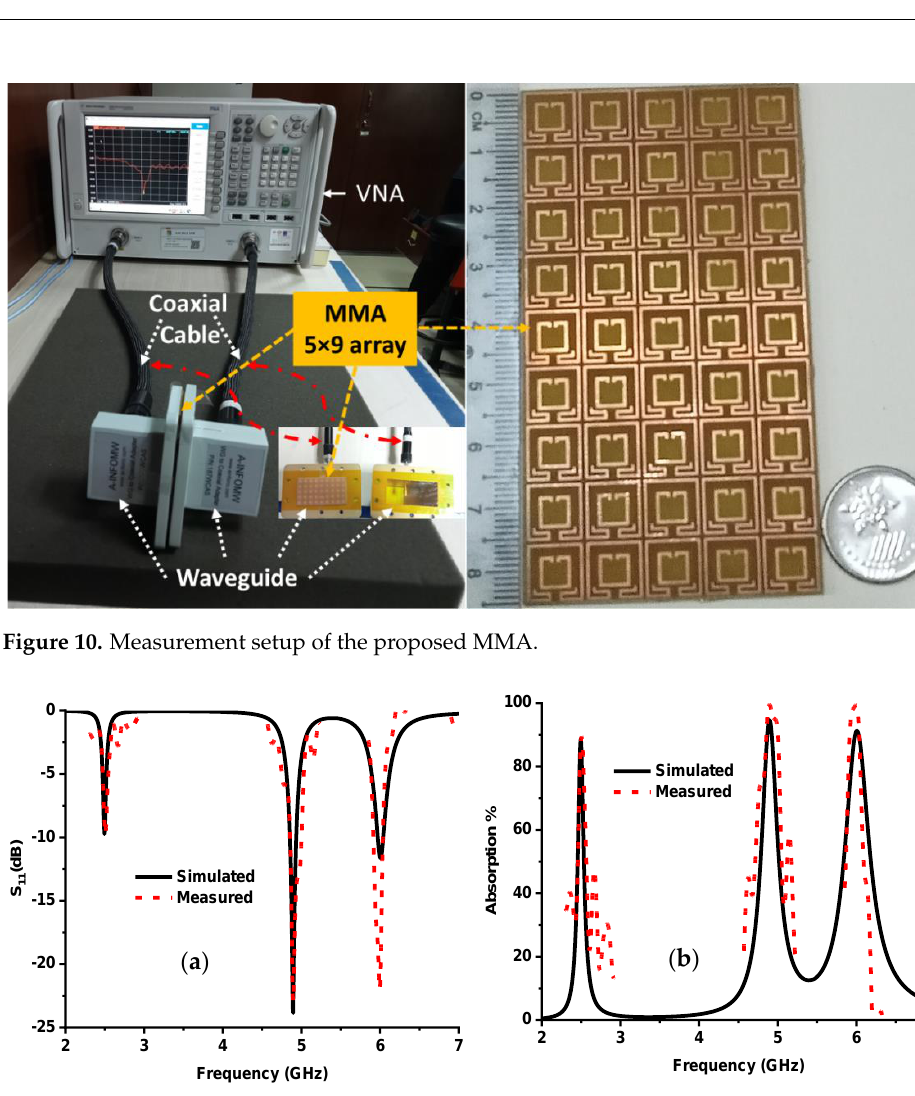
Figure 11. Simulated and measured results: ( a ) S11 parameters in dB, ( b ) absorption %. Table 5. Comparisons with existing